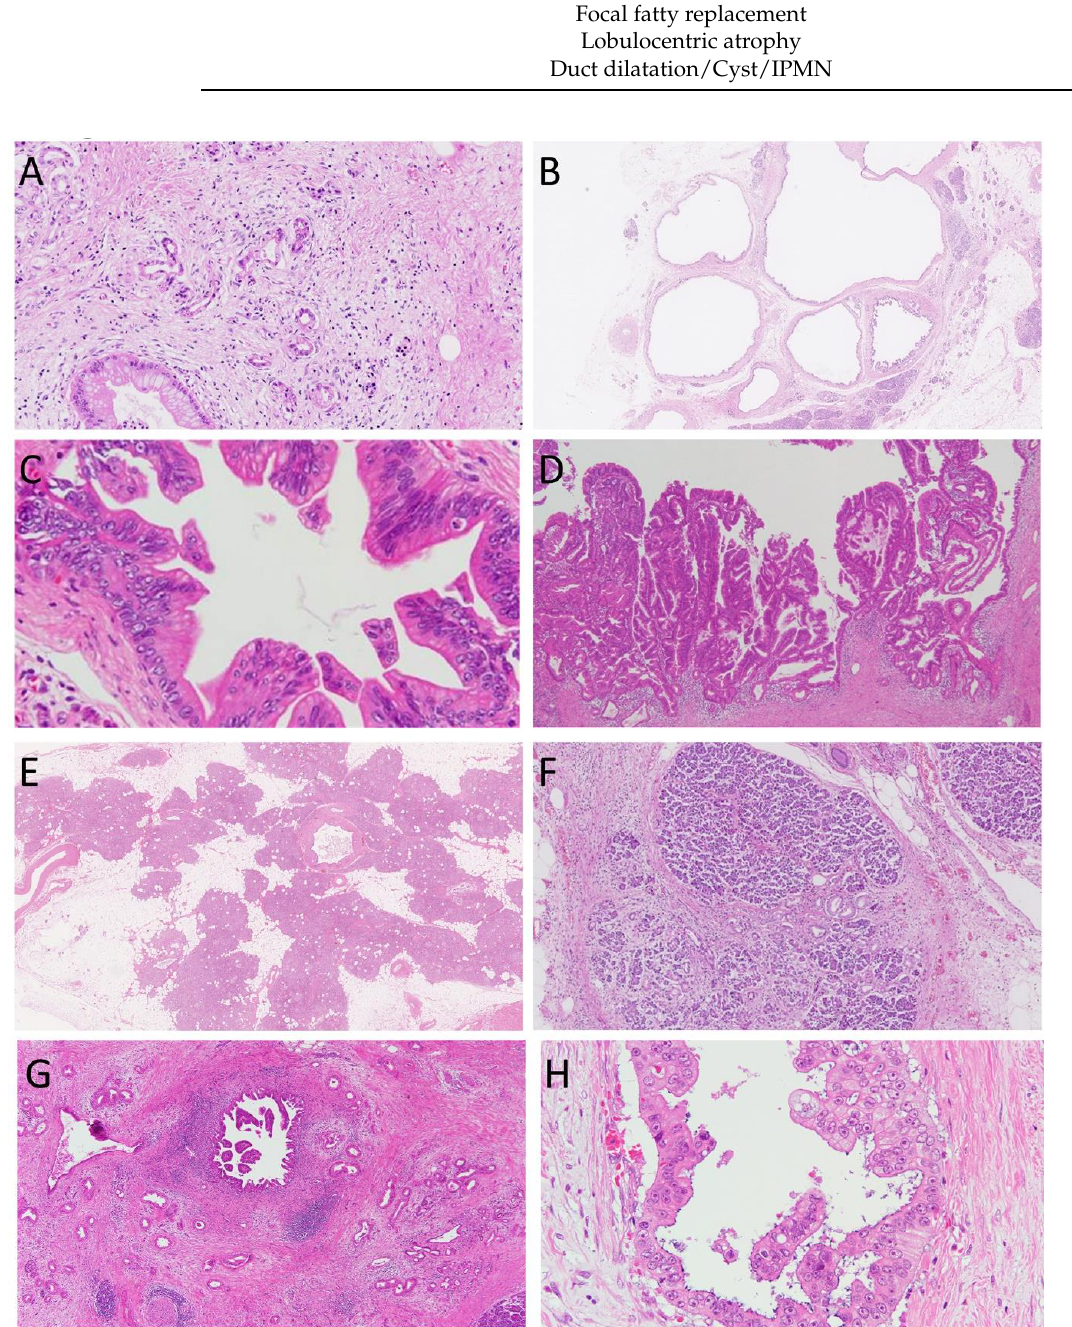
Figure 1. Cancer-related lesions of the pancreas. ( A ), acinar-to-ductal metaplasia, ( B ), cyst, ( C ), pancreatic intraepithelial neoplasia, ( D ), intraductal papillary mucinous neoplasm, ( E ), fatty replacement, ( F ), lobulocentric atrophy, ( G ), and ( H ), pancreatic ductal carcinoma. Hematoxylin and eosin staining. Original magnification, ( A , C , H ), ×400; ( B , E ), ×40; ( D , F , G ), ×100.